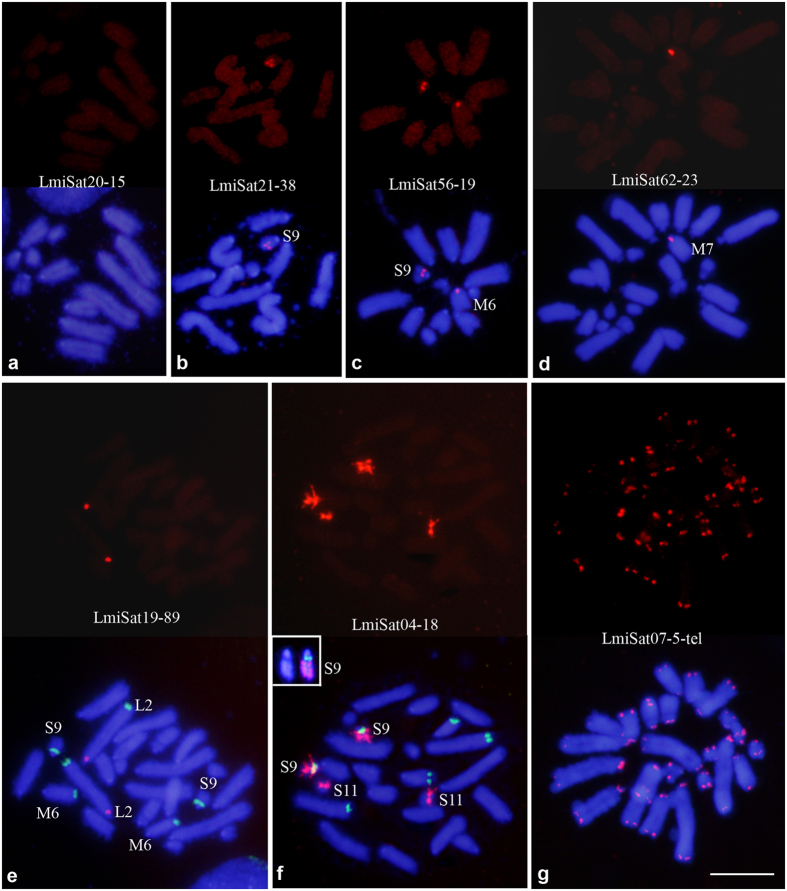
Physical mapping of seven of the short satDNAs found in Locusta migratoria, showing the three patterns of chromosome distribution observed: non-clustered (a), clustered (d–g) and mixed (b,c). (a–c) show haploid mitotic metaphase cells from haplo-diploid embryos, whereas (d–g) show diploid cells from normal embryos. Each cell is shown in red color for satDNA FISH (upper panel) and merged with DAPI (lower panel). In (e,f) double FISH was performed to distinguish whether the sat-carrying chromosome was L2 instead of L1 (e) and whether S9 carried LmiS at04–18 in addition to rDNA (shown in green color) (f). Inset in (f) shows the S9 chromosome stained with DAPI, on the left, and submitted to double FISH for LmiSat04–18 (red) and rDNA (green), on the right, which was selected from another cell showing lower chromosome condensation. Note the presence of three about similar sized satDNA blocks located in interstitial and distal regions of the S9 chromosome. In (g) note that LmiSat07–5-tel shows the typical pattern of telomeric repeats.